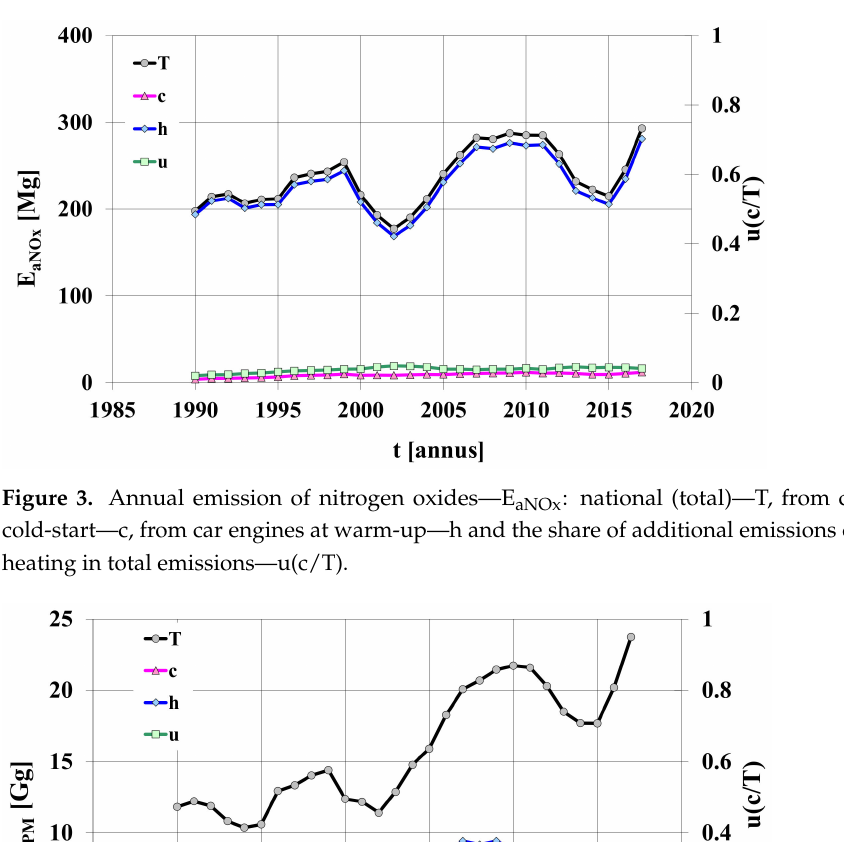
Figure 2. Annual emission of non-methane volatile organic compounds: E aNMVOC : national (total)—T, from car engines at cold-start—c, from car engines at warm-up—h and the share of additional emissions during engine heating in total emissions—u(c/T).